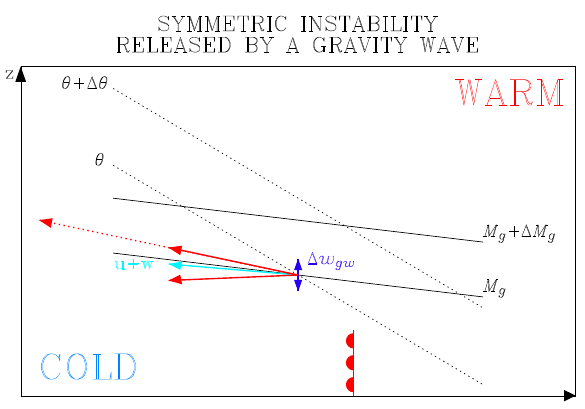
Fig. 9. Symmetric instability released by a gravity wave perturbation. The slopes of isolines of θ and M g in the x-z plane are such that ∂θ / ∂z> 0 and ∂M g / ∂x> 0, meaning that the atmosphere is stable to purely vertical and horizontal displacements. Slantwise displacements with intermediate slopes between the isolines of θ and M g are symmetrically unstable. A vertical perturbation 1 w gw due to a gravity wave (dark blue) vectorially added to the upward tilting flow (light blue) in the vicinity of a warm front will release the MSI, thus leading to slantwise convection.